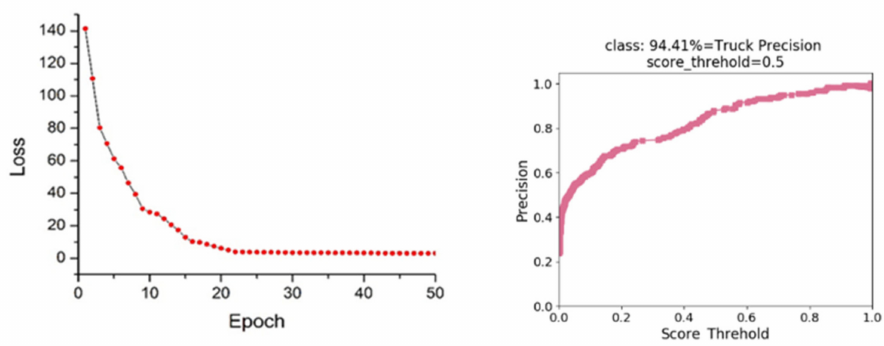
Figure 7. Model training loss curve and detection accuracy of